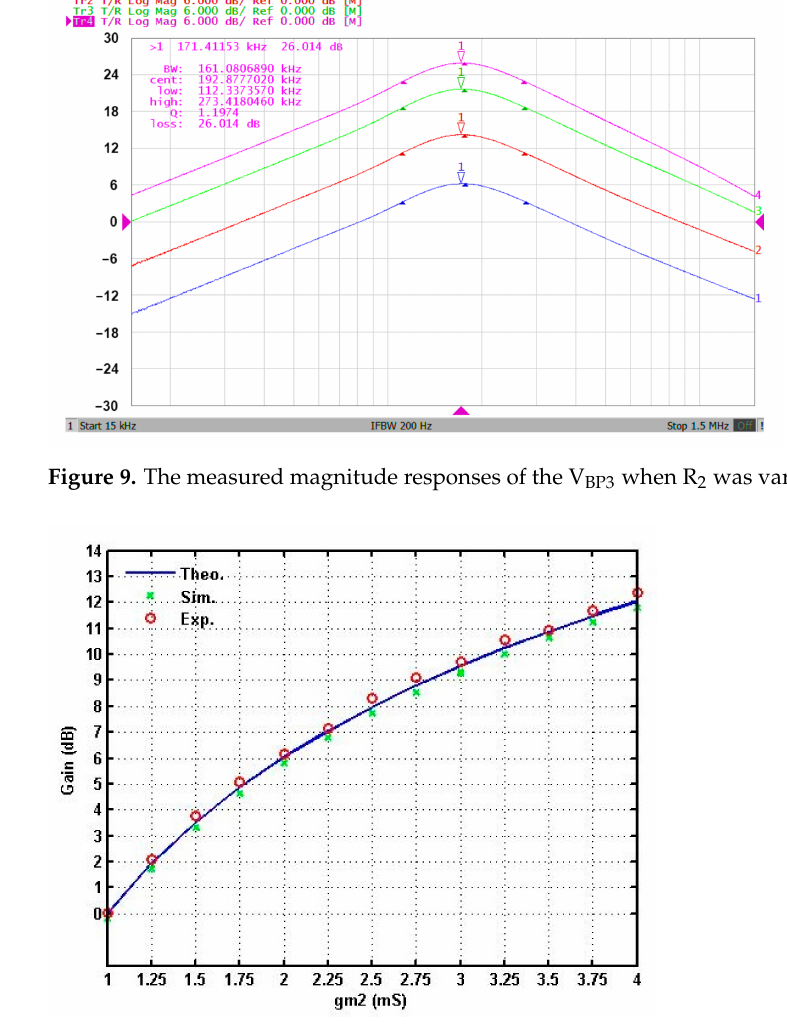
Figure 10. The theoretical, simulated and measured results of the electronic amplitude adjustable NBPF voltage gains at the voltage output of V BP2